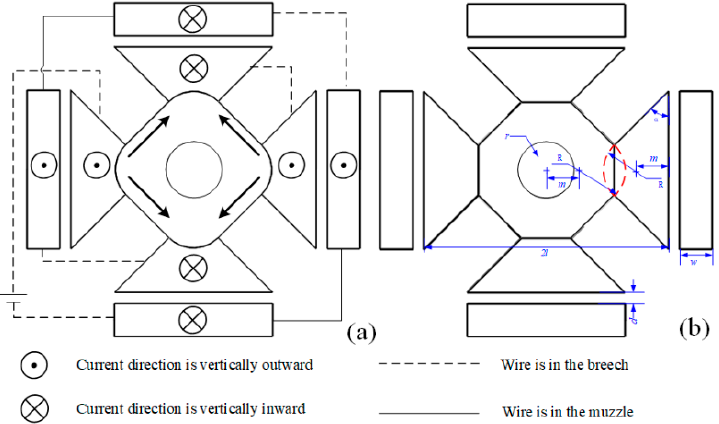
Figure 3. Three matching forms of armature and rails. ( a ) Schematic of the circuit connection. ( b ) Schematic of the structure and size of the railgun.